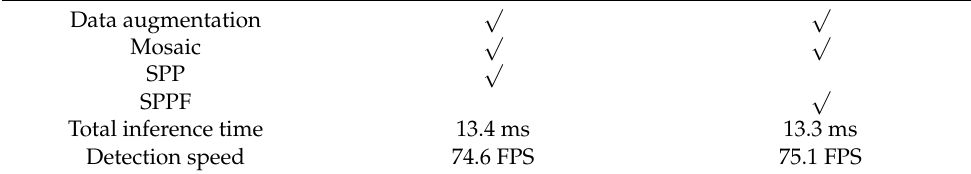
Table 5. Comparison between the SPP and SPPF.